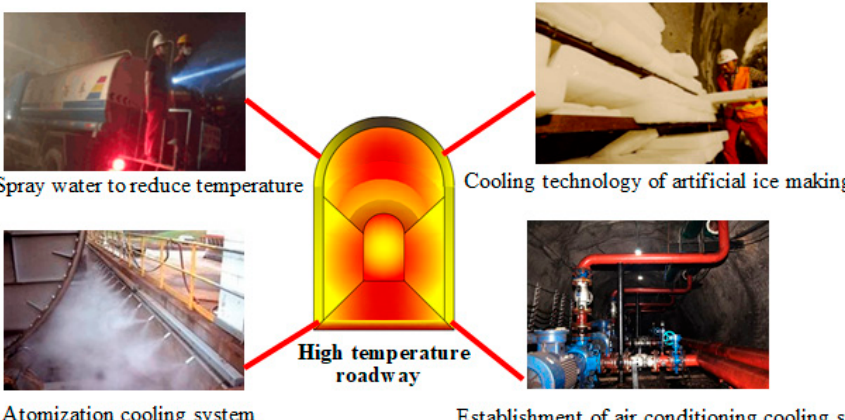
Figure 17. Refrigeration technology in high temperature construction environments.